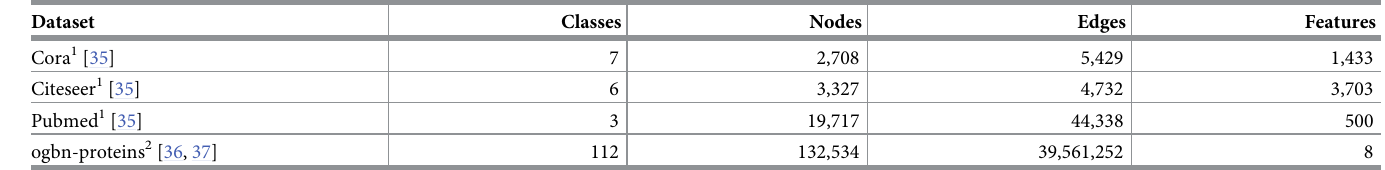
Table 2. Dataset